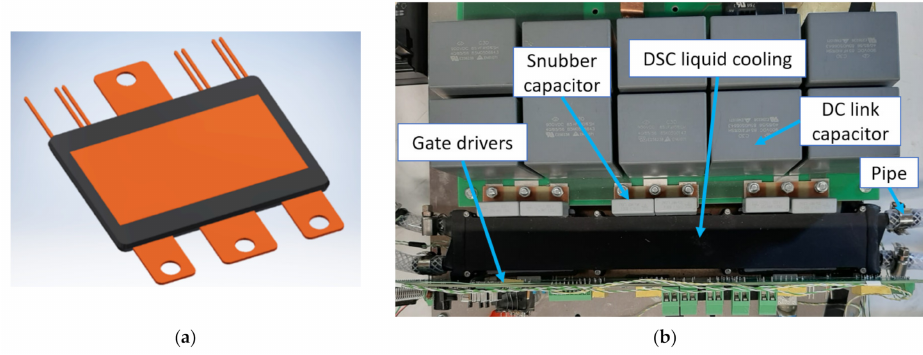
Figure 16. AFE with liquid cooling; ( a ) half–bridge DSC module, ( b ) DSC modules with